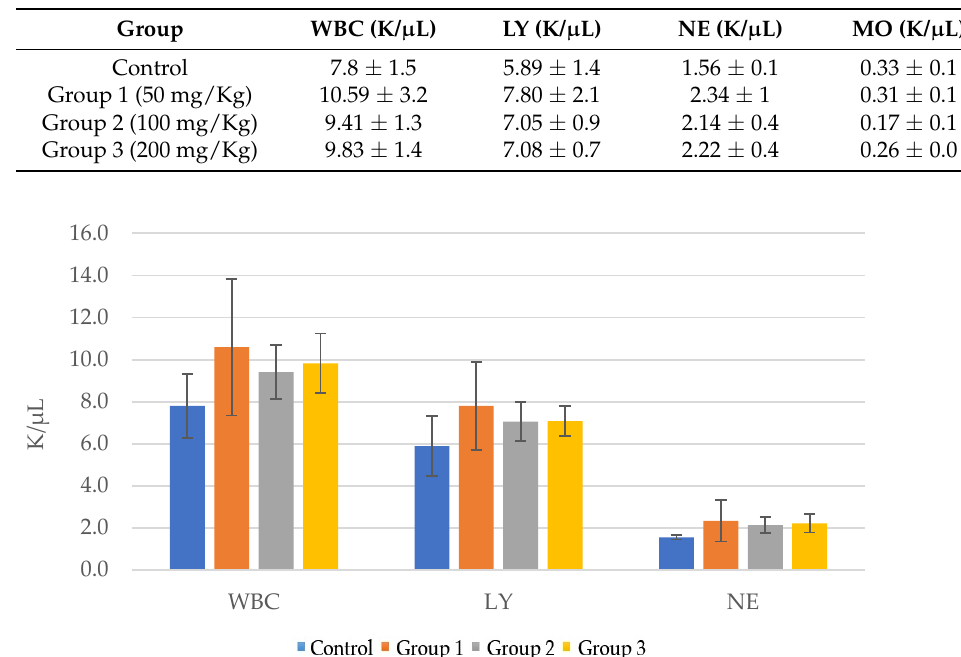
Figure 11. Evaluation of the number of leukocytes in the groups that received the novel nutraceutical compared to the control group: total numbers of leukocytes (WBC), lymphocytes (LY) and neutrophils (NE) in mice .